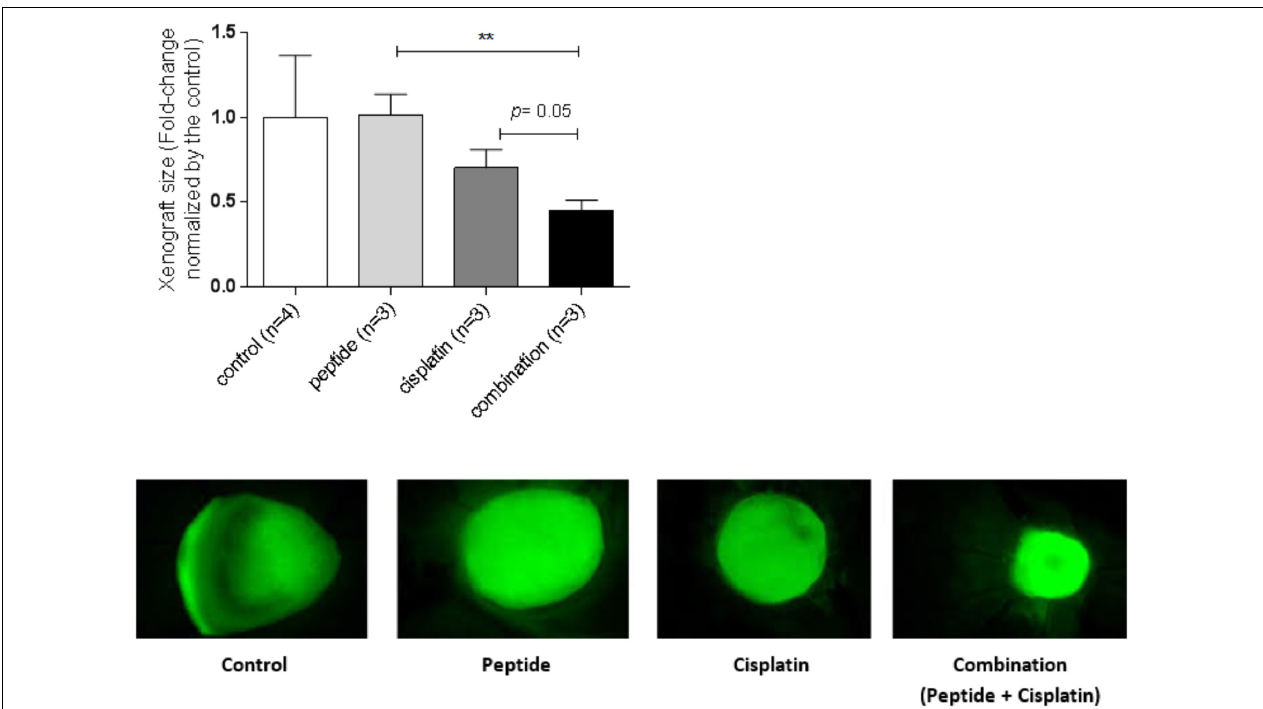
FIGURE 7 | The ApoA1 mimetic peptide sensitizes ovarian cancer cells to cisplatin in the biologically relevant in ovo CAM model. SKOV3 xenografts were topically inoculated on the CAM, left untreated (control) or treated with the ApoA1 mimetic peptide (100 µ g/mL), cisplatin (15 µ M) or with the combination of both (100 µ g/mL peptide plus 15 µ M cisplatin). Xenograft size was calculated as the area of the fluorescent tumor relative to background. Student’s t -test was performed after testing the data normality by the Shapiro–Wilk normality test. Differences were considered significant if p < 0.05. ∗∗ p <